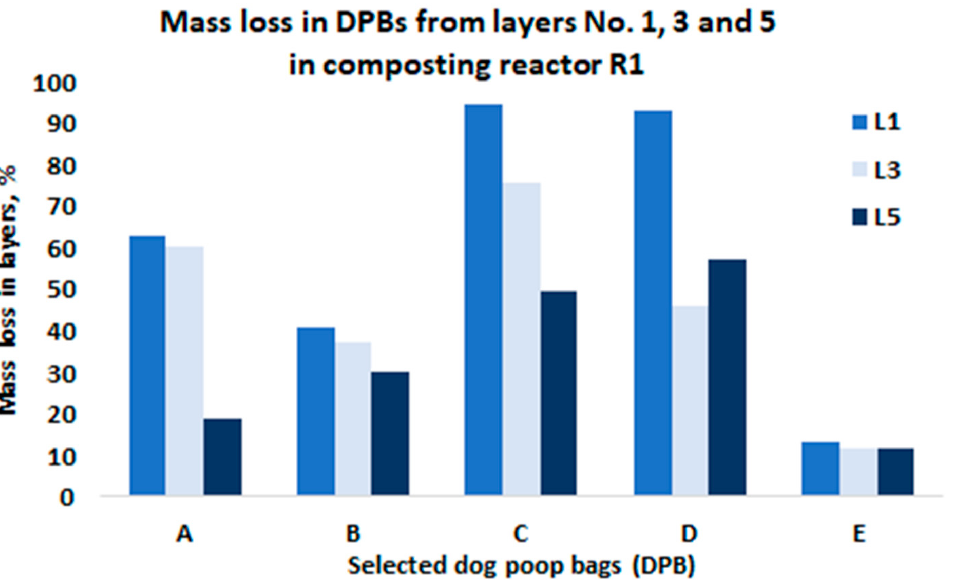
Figure 5. Mass loss of the investigated dog poop bags sampled from the layers in the composting reactor R1.